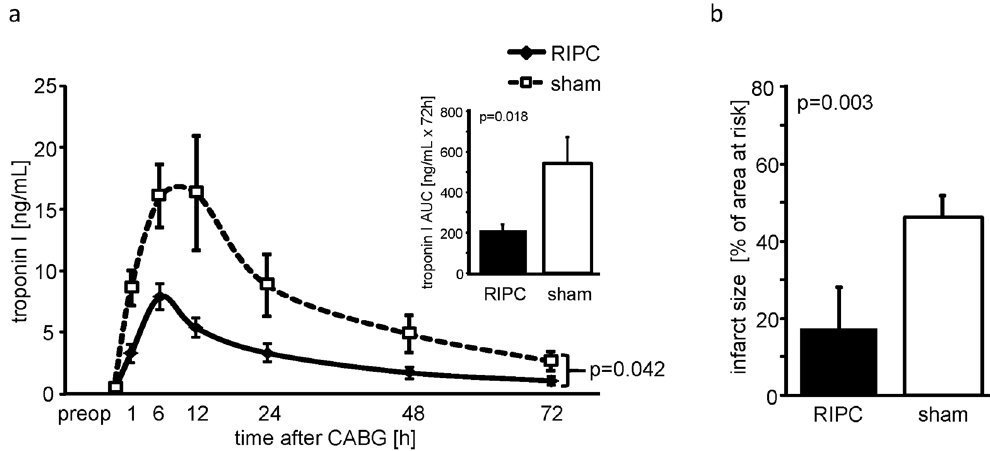
Figure 1. Serum concentration of troponin I of patients. ( a ) The serum concentration of troponin I before (preop) and over 72 h after coronary artery bypass grafting (CABG) in patients undergoing remote ischemic preconditioning (RIPC; black symbols/bars) or sham (white symbols/bars). Decreased troponin I concentrations confirmed protection by RIPC. Insert: area under the curve (AUC) for serum troponin I concentrations over 72 h. ( b ) Infarct size of pigs after 60 min coronary occlusion and 180 min reperfusion. Protection by RIPC was confirmed by infarct size reduction. Data are mean ± standard error of the mean. The data were compared using a 2-way (group, time) ANOVA for repeated measures or using unpaired Student’s t-test (AUC, infarct size).